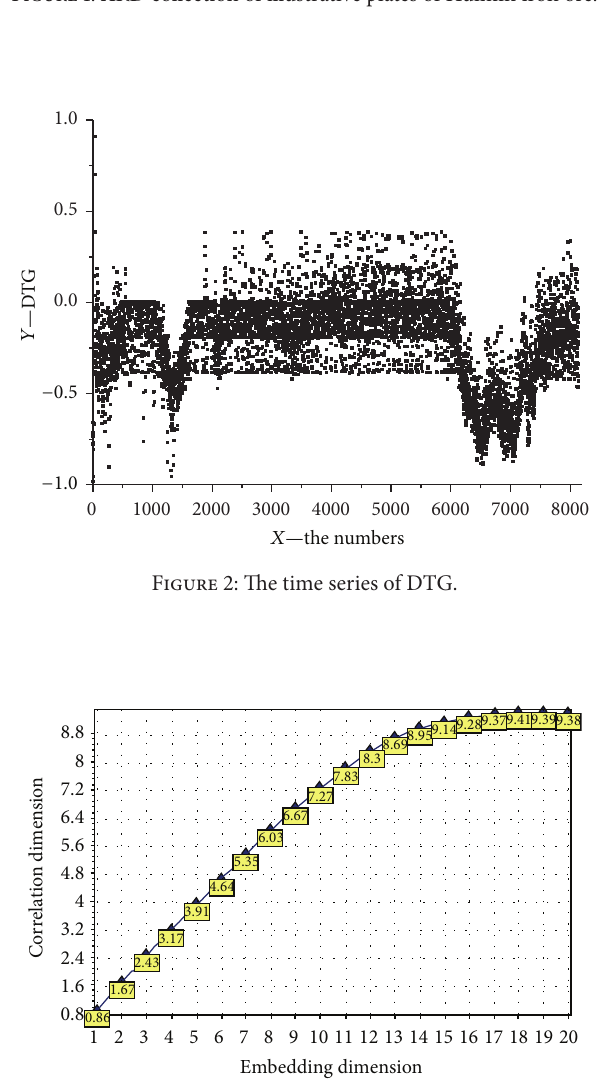
Figure 1: XRD collection of illustrative plates of Huimin iron ore.